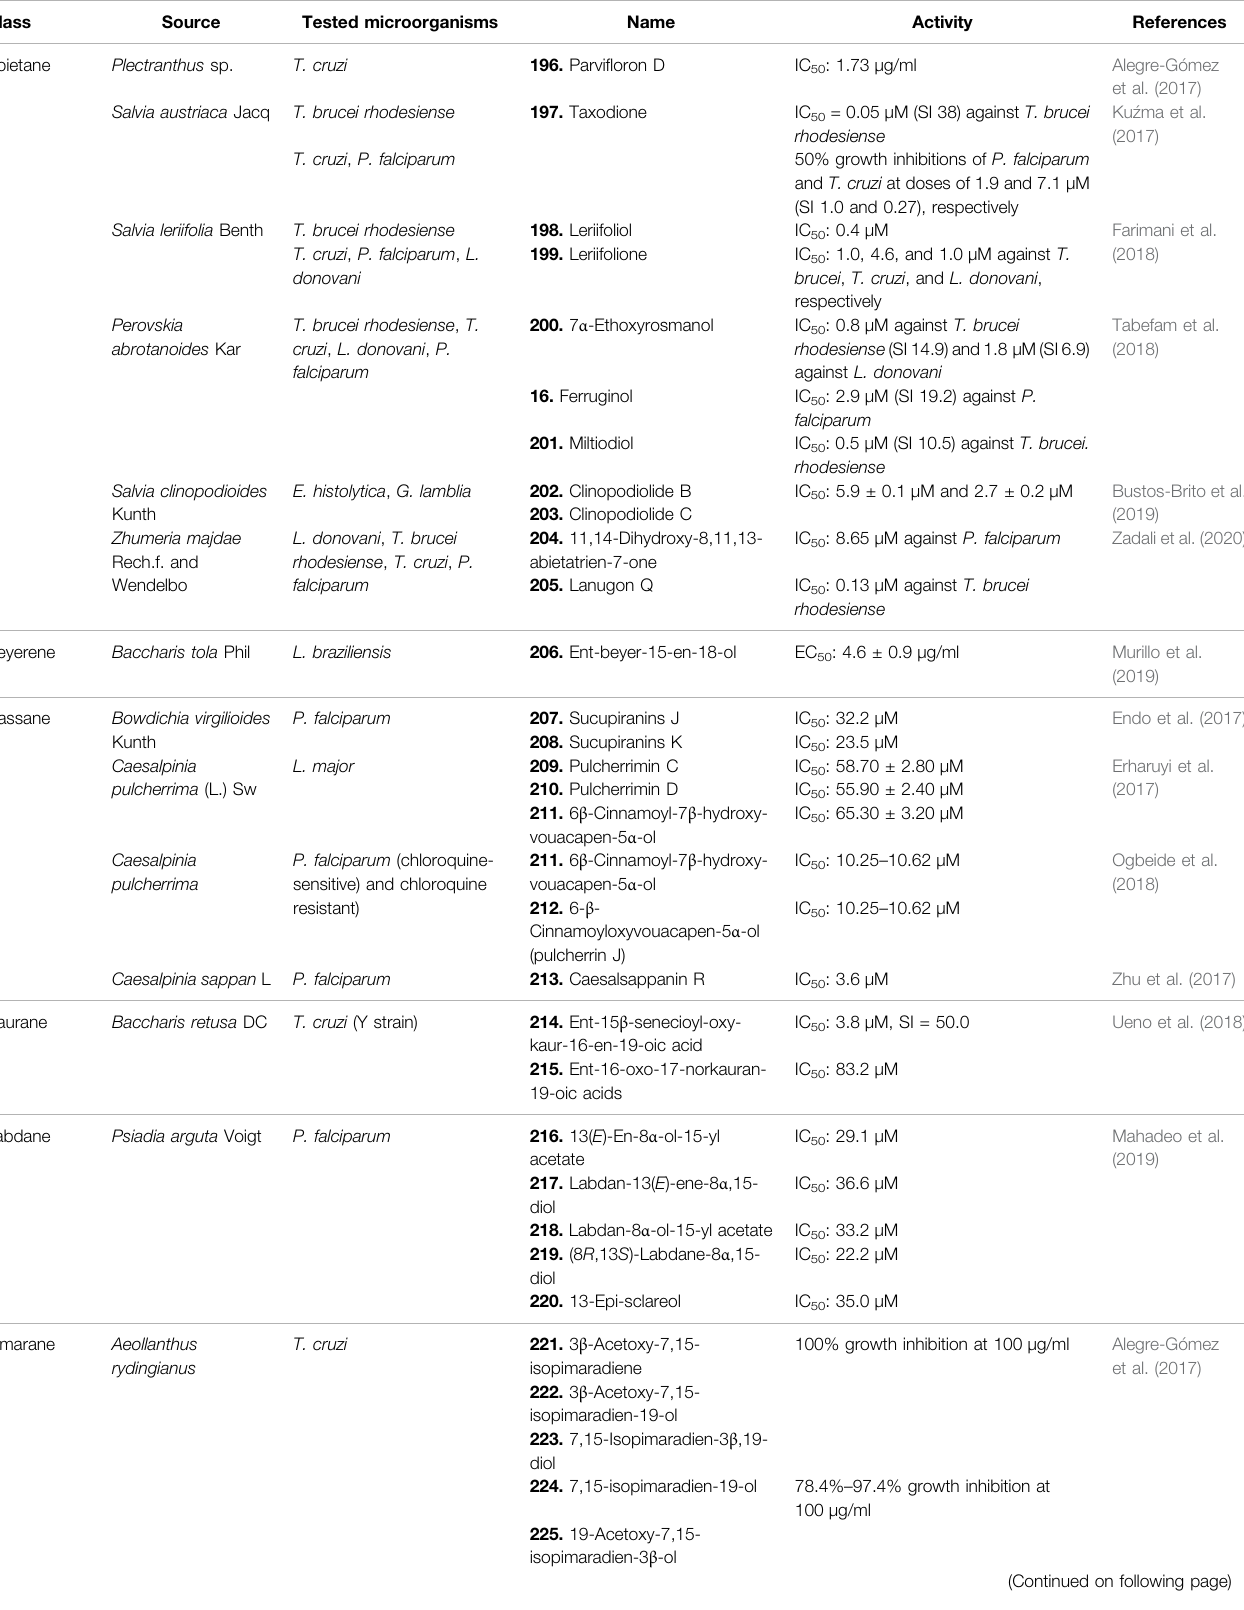
TABLE 4 | Different classes of diterpenoids isolated from natural sources with signi fi cant antiprotozoal activity.